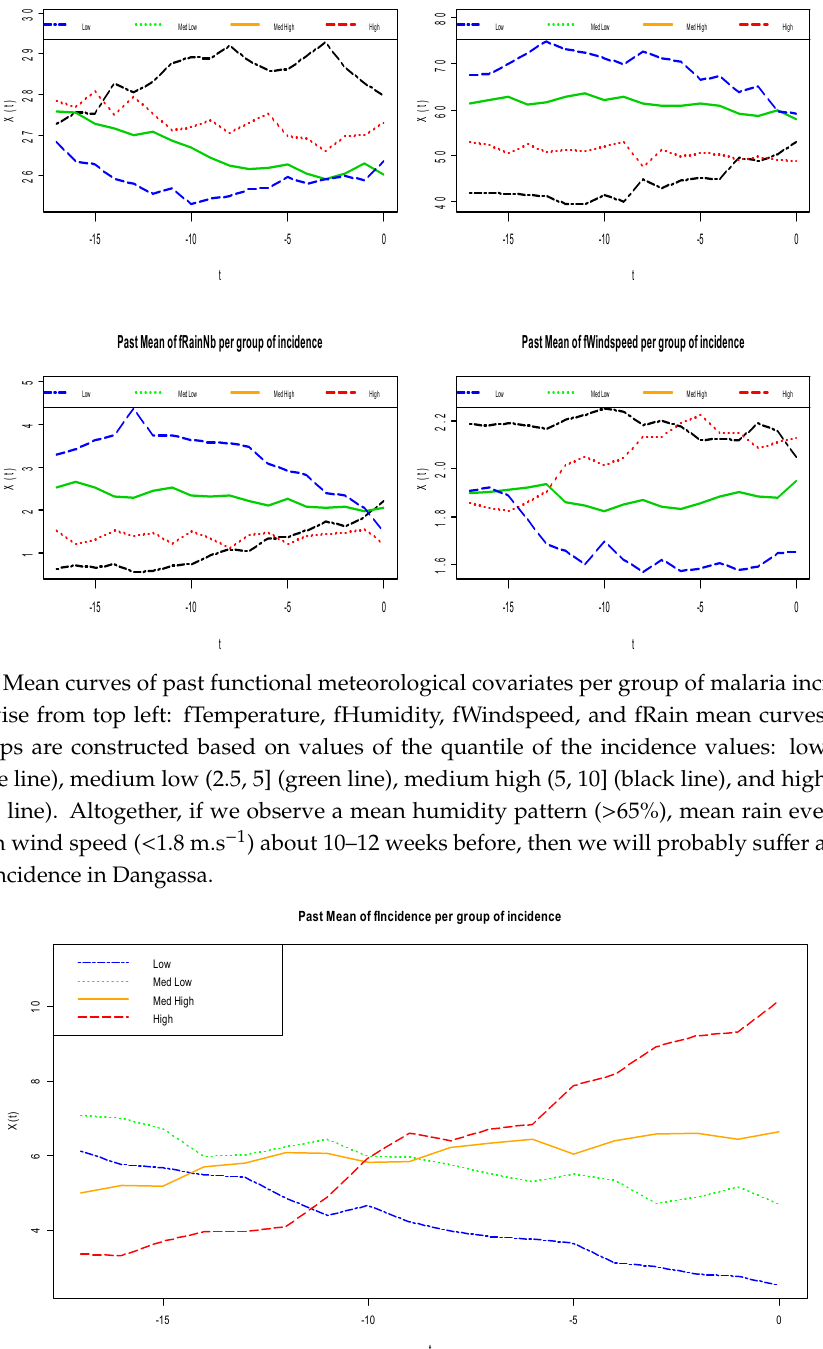
Figure 3. Mean curve patterns of past malaria incidence per group of incidence c. c The groups are constructed based on values of the quantile of the incidence values: low [0, 2.5] (dark blue line), medium low (2.5, 5] (green line), medium high (5, 10] (black line), and high (10, 20] (dark red line). Descriptive analysis shows a slow decline for lower incidence rates and a high and abrupt increasing pattern at weeks 10.